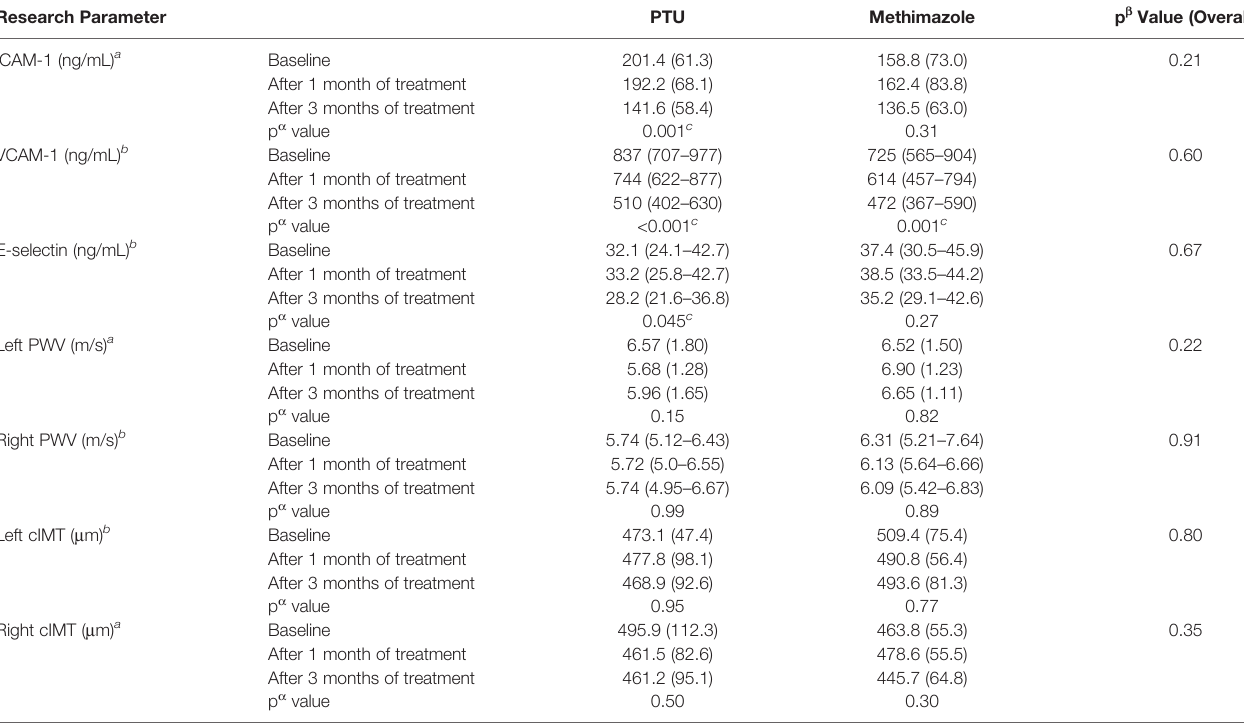
TABLE 3 | Changes in vascular atherosclerosis marker after 3 months of anti-thyroid treatment in PTU and methimazole groups. Research